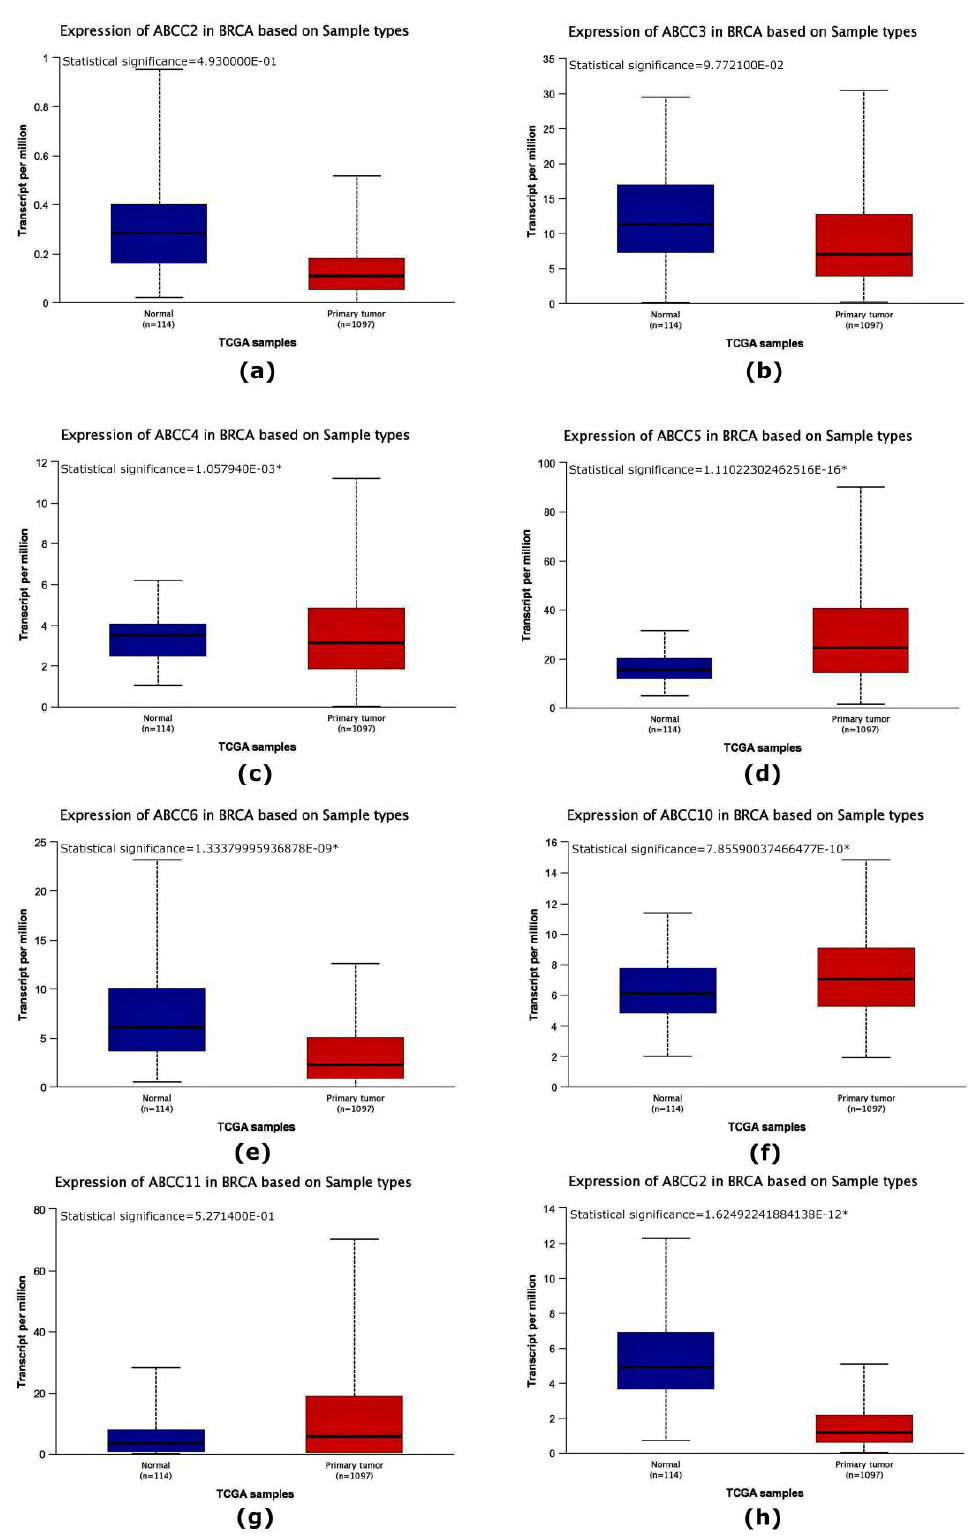
Figure 2. A comparison of the expression levels of the ABCC2 ( a ), ABCC3 ( b ), ABCC4 ( c ), ABCC5 ( d ), ABCC6 ( e ), ABCC10 ( f ), ABCC11 ( g ), and ABCG2 ( h ) genes in breast cancer patients compared to normal tissue obtained from the TCGA database using the Ualcan web tool. Statistically significant values are marked with *.